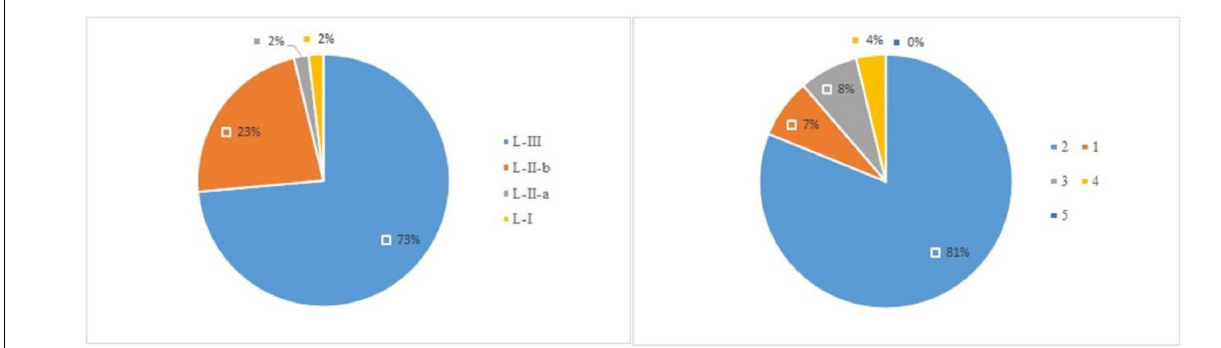
FIGURE 4 | The primary study distribution in groups (left), and in study quality (right).